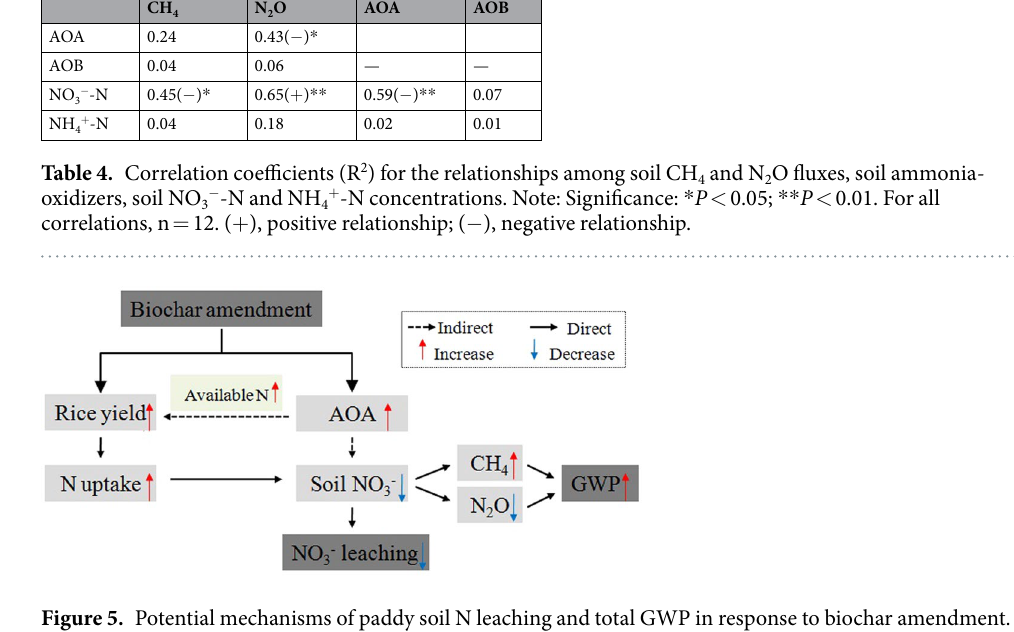
Figure 5. Potential mechanisms of paddy soil N leaching and total GWP in response to biochar